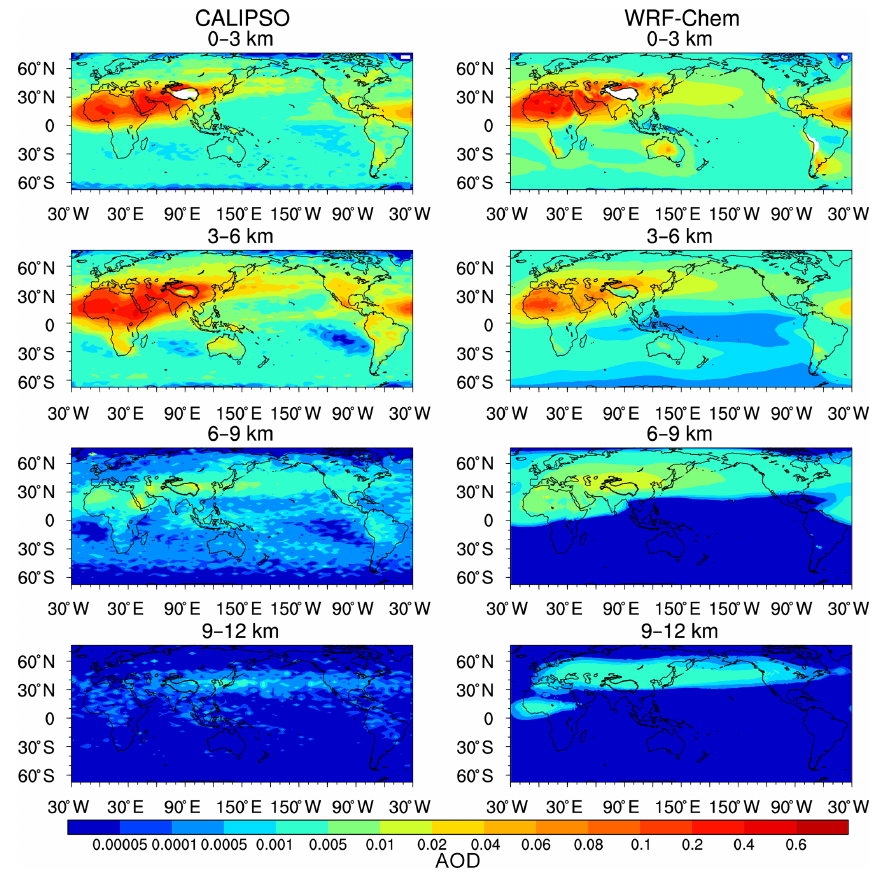
Figure 3. Spatial distributions of annual mean dust AOD from CALIPSO (left) and WRF-Chem (right) between 0–3, 3–6, 6–9, and 9–12km for the period of